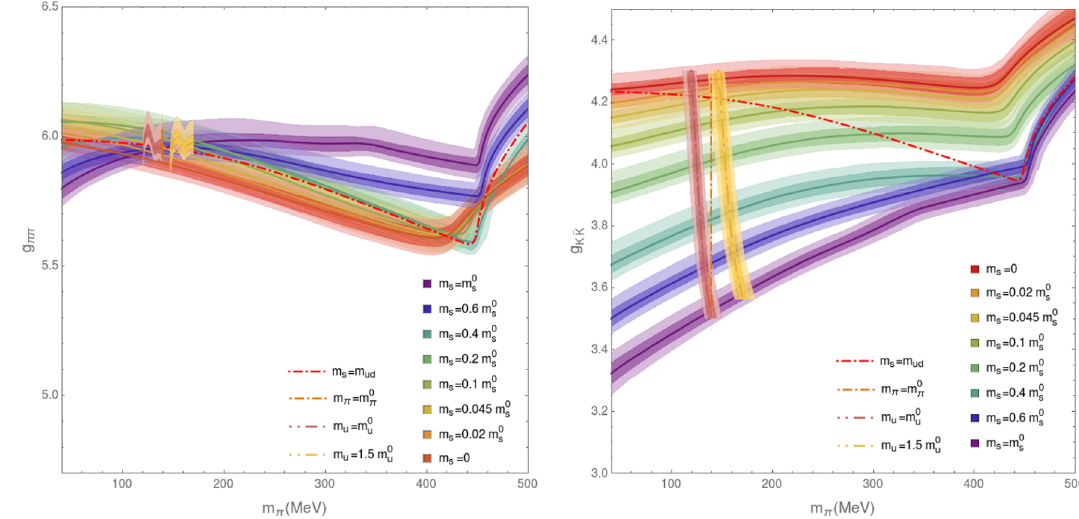
Figure 34 . The couplings of the (cid:26) -meson pole to the (cid:25)(cid:25) and K (cid:22) K channels, g (cid:25)(cid:25) and g m s = k , m u = c , m (cid:25) = m 0